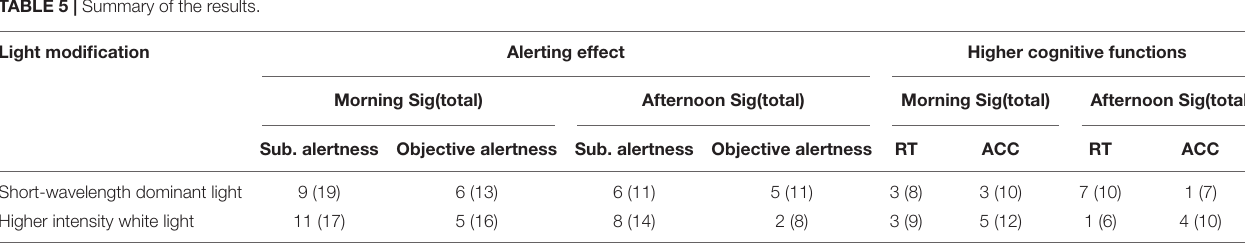
FIGURE 4 | The trend of IIL literature focusing on alertness and higher cognitive functions. TABLE 5 | Summary of the